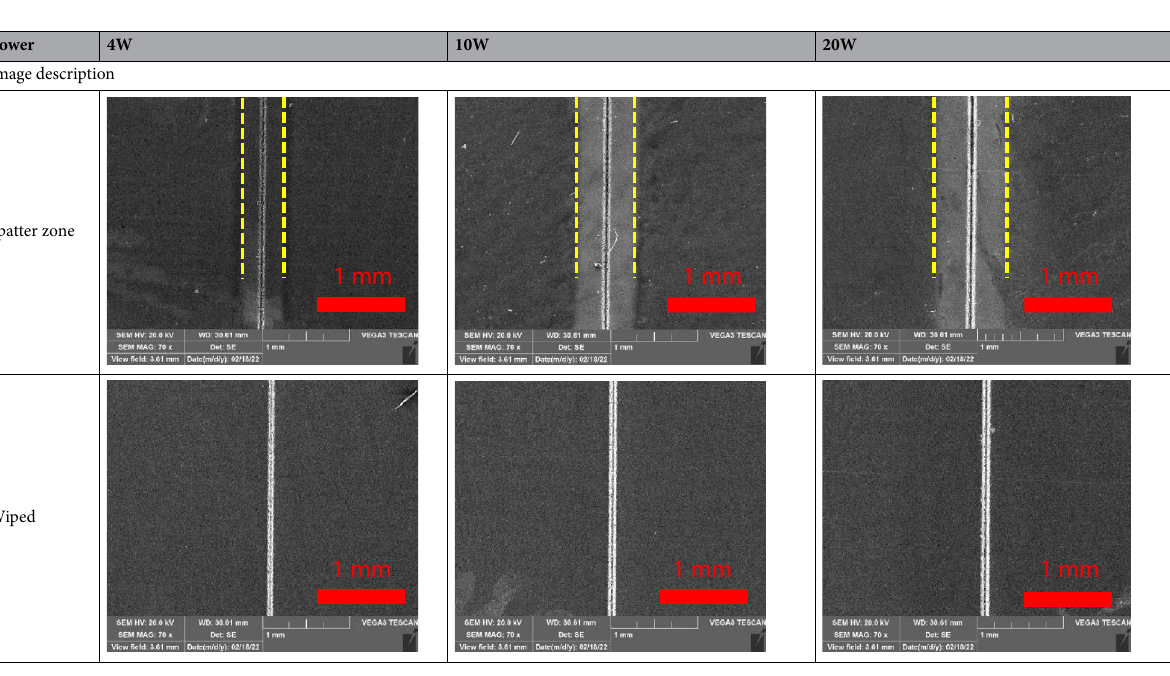
Table 3. Relationship of the spatter with